Question: What does this figure show? Answer in one sentence.
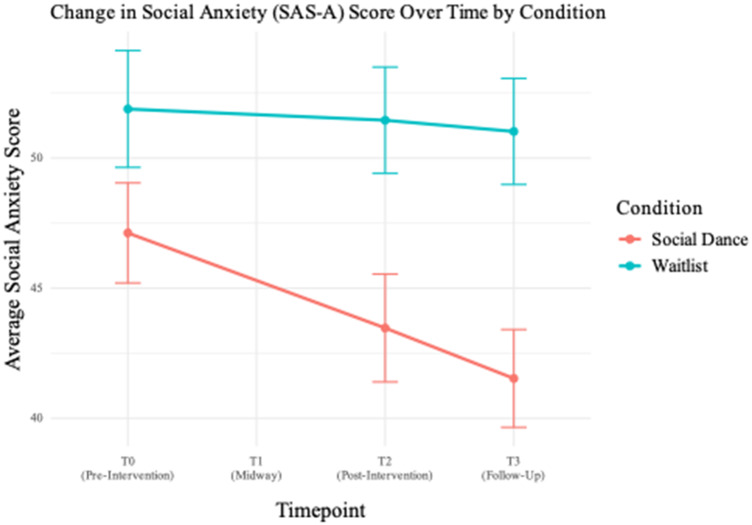
Answer: Change in SAS-A scores over time by condition. Note: this measure was only administered at baseline (T0), following the salsa classes (T2), and follow-up (T3), e.g. not administered at T1. n = 93. Figure 3. long description.